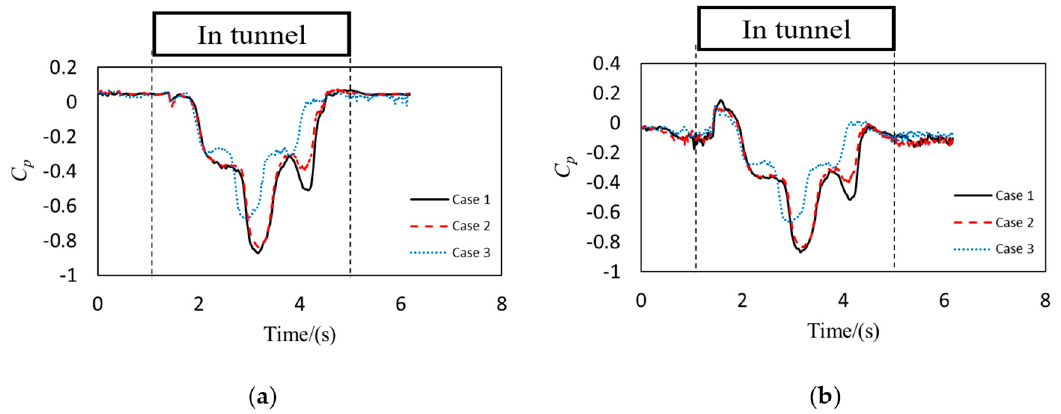
Figure 12. (cid:1829) (cid:3043) curves of the measuring points on the middle car: ( a ) windward side; ( b ) leeward